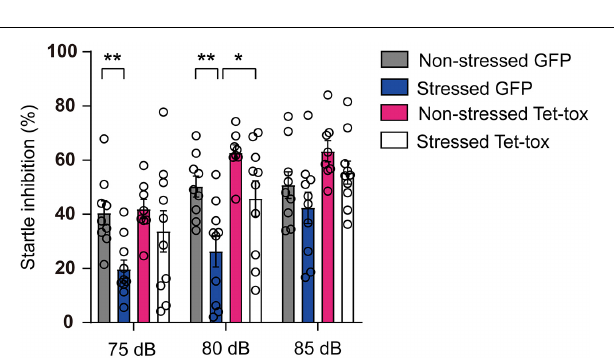
FIGURE 6 | Effect of ZI silencing on RSDS-induced PPI deficit. The startle inhibition ratio of mice was examined after RSDS training. The stressed GFP mice showed a significantly lower startle inhibition rate than the non-stressed GFP mice in 75 and 80 dB groups, while the startle inhibition rate was significantly increased in the stressed Tet-tox mice compared to the stressed GFP mice in 80 dB group. Two-way ANOVA with bonferroni post hoc test was used to compare the startle inhibition rate of non-stressed and stressed GFP mice, and was also used to compare the startle inhibition rate of stressed GPF mice and stressed Tet-tox mice. * p < 0.05, ** p <